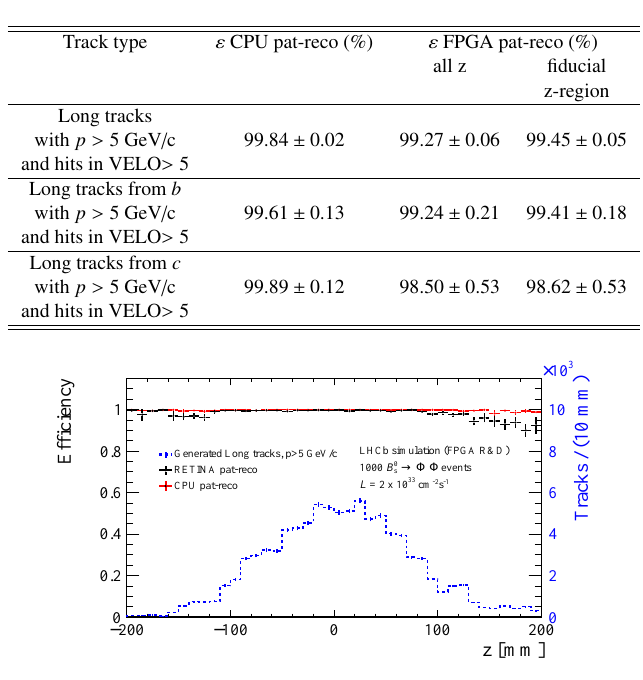
Table 1. Summary of e ffi ciencies of the VELO tracking algorithm for di ff erent type of tracks using both the CPU-based and the FPGA-based pattern recognition algorithm. Numbers obtained on 1000 → ΦΦ events. The e ffi ciency (defined as the number of reconstructed tracks divided by the number B 0 s of reconstructible tracks, i . e . tracks with at least 3 hits in the VELO) is calculated using Long tracks, i . e . tracks crossing all the tracking sub-detectors, with 2 < η < 5, p > 5 GeV / c and with more than 5 hits (Monte Carlo truth) in the VELO detector. Tracks belong to the fiducial region if the z coordinate of the origin vertex is located between -200 mm and 200 mm.